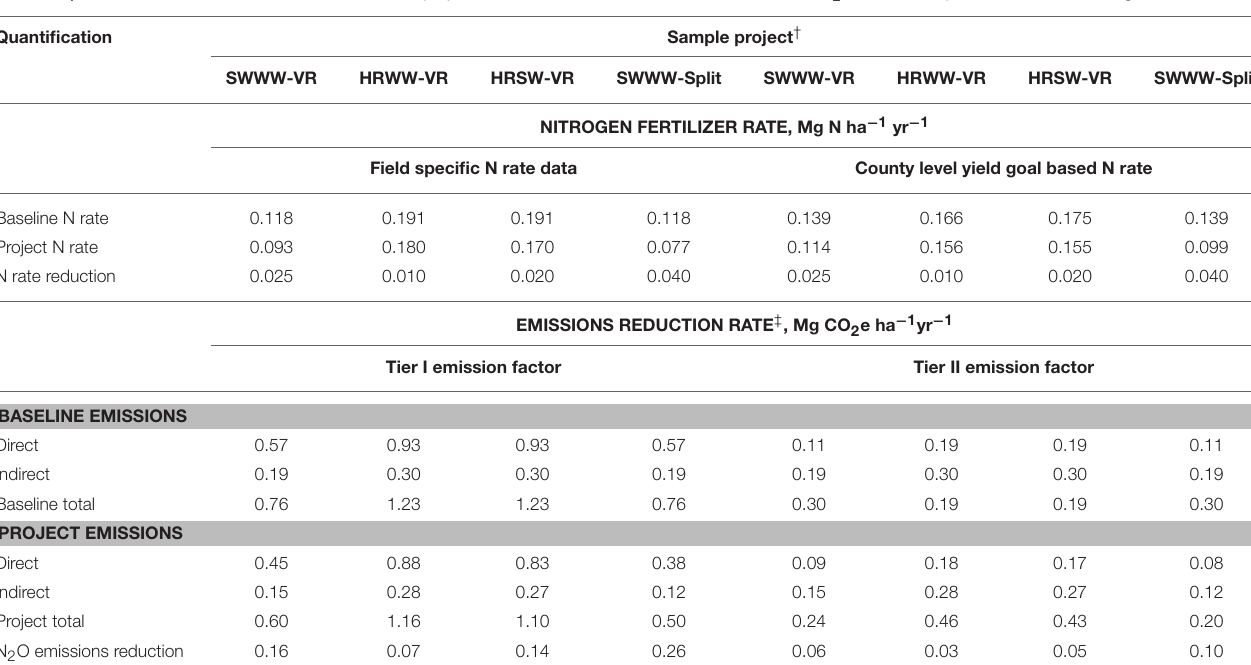
TABLE 6 | Direct and indirect emissions for baseline and project conditions under different baseline and direct N 2 O emissions quantification methodologies.